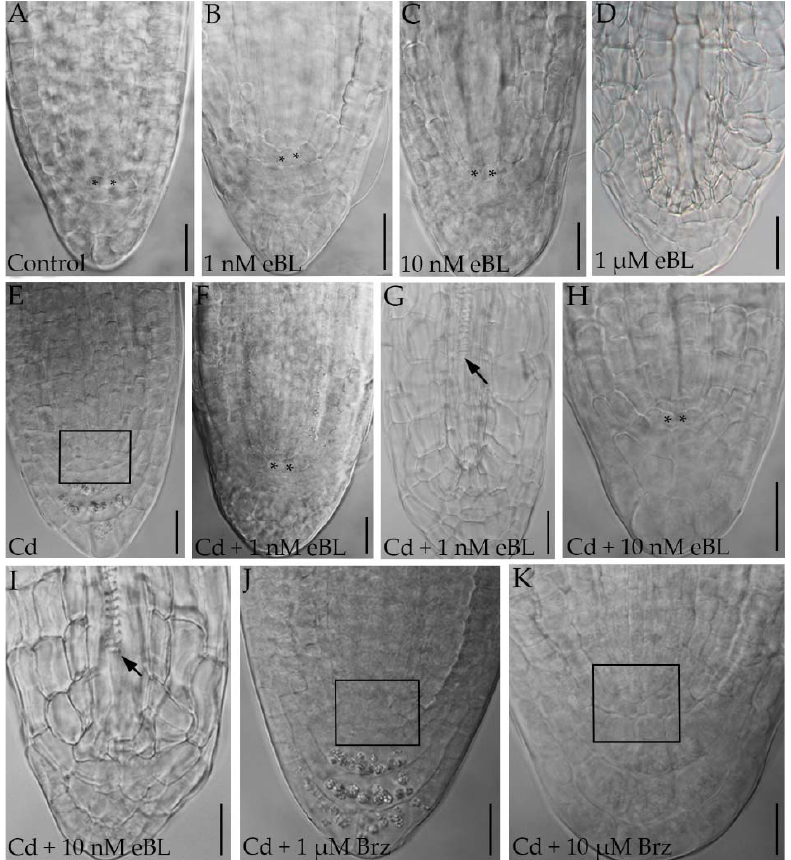
Figure 3. Nomarski images of adventitious root apices of Col seedlings cultured for 9 days under continuous darkness followed by 7 days under 16 h light/8 h darkness photoperiod on ½ MS me ‐ dium (see Section 4) (Control treatment) ( A ) or on the same medium plus either 1nM eBL ( B ), or 10